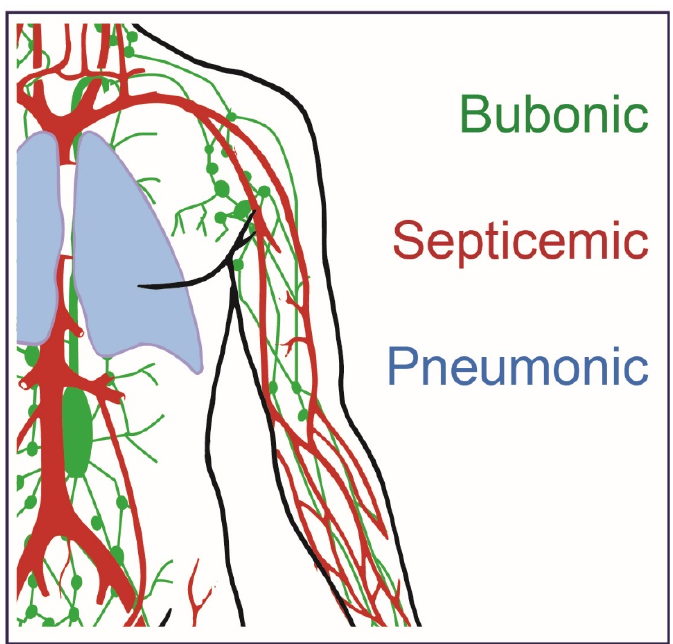
Figure 1. Y. pestis infection can lead to three forms of plague. Bubonic plague can result from flea bites or handling infected animals and can result in a severe localized infected lymph node referred to as a buboe (green). Septicemic plague can result as a secondary issue arising from bubonic disease or if the bacteria are introduced directly to the blood stream (red). Pneumonic plague is the most severe form of the disease and can result in person-to-person spread if untreated and initiated by the deposition of Y. pestis bacteria into the respiratory tract of individuals (blue).